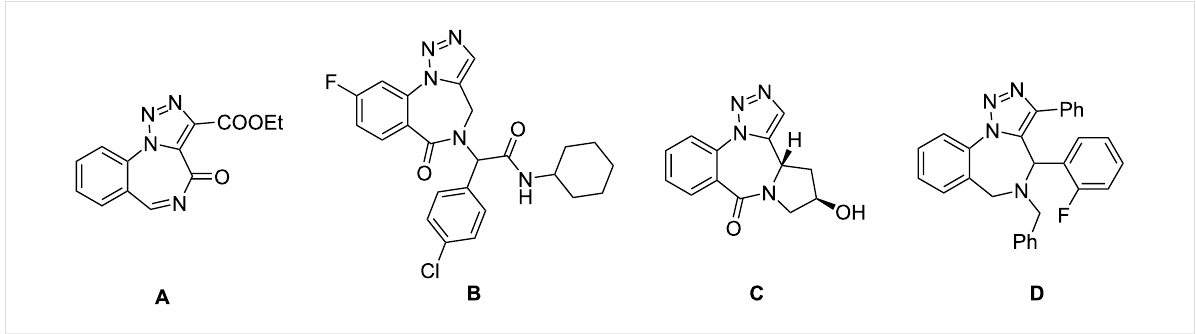
Figure 2: Novel potential 1,2,3-triazolobenziadiazepine drugs.